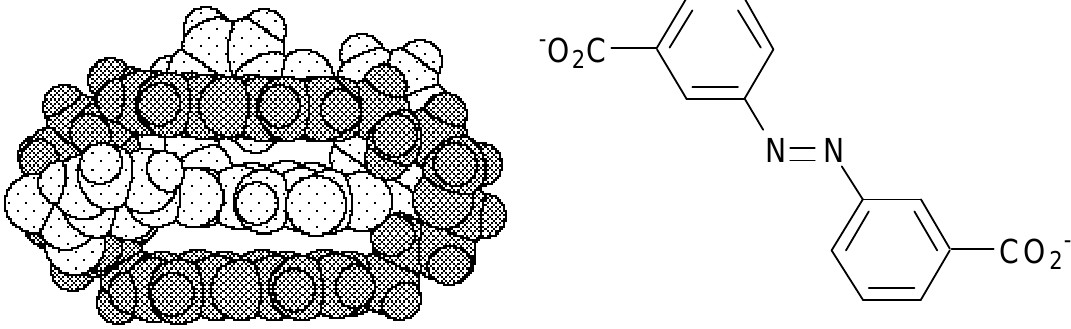
Figure 6. Crystal structure of the inclusion complex of the bisacridine receptor with trans 3,3’- azo- benzenedicarboxylate in space filling